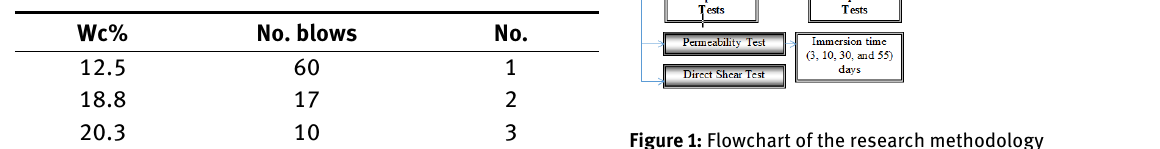
Table 2: Results of the liquid limit test of the untreated gypseous soil [ASTM D4254-2000]